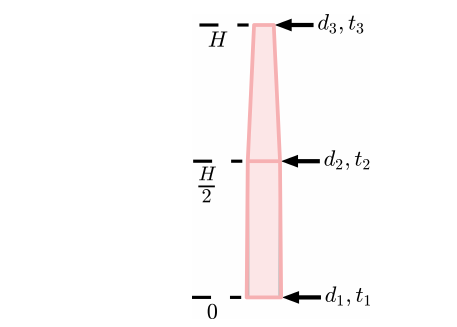
Figure 3. The parameterized turbine tower definition. The tower di- ameter and shell thickness are defined at the bottom, midpoint, and top of the tower, with the values linearly interpolated in between.